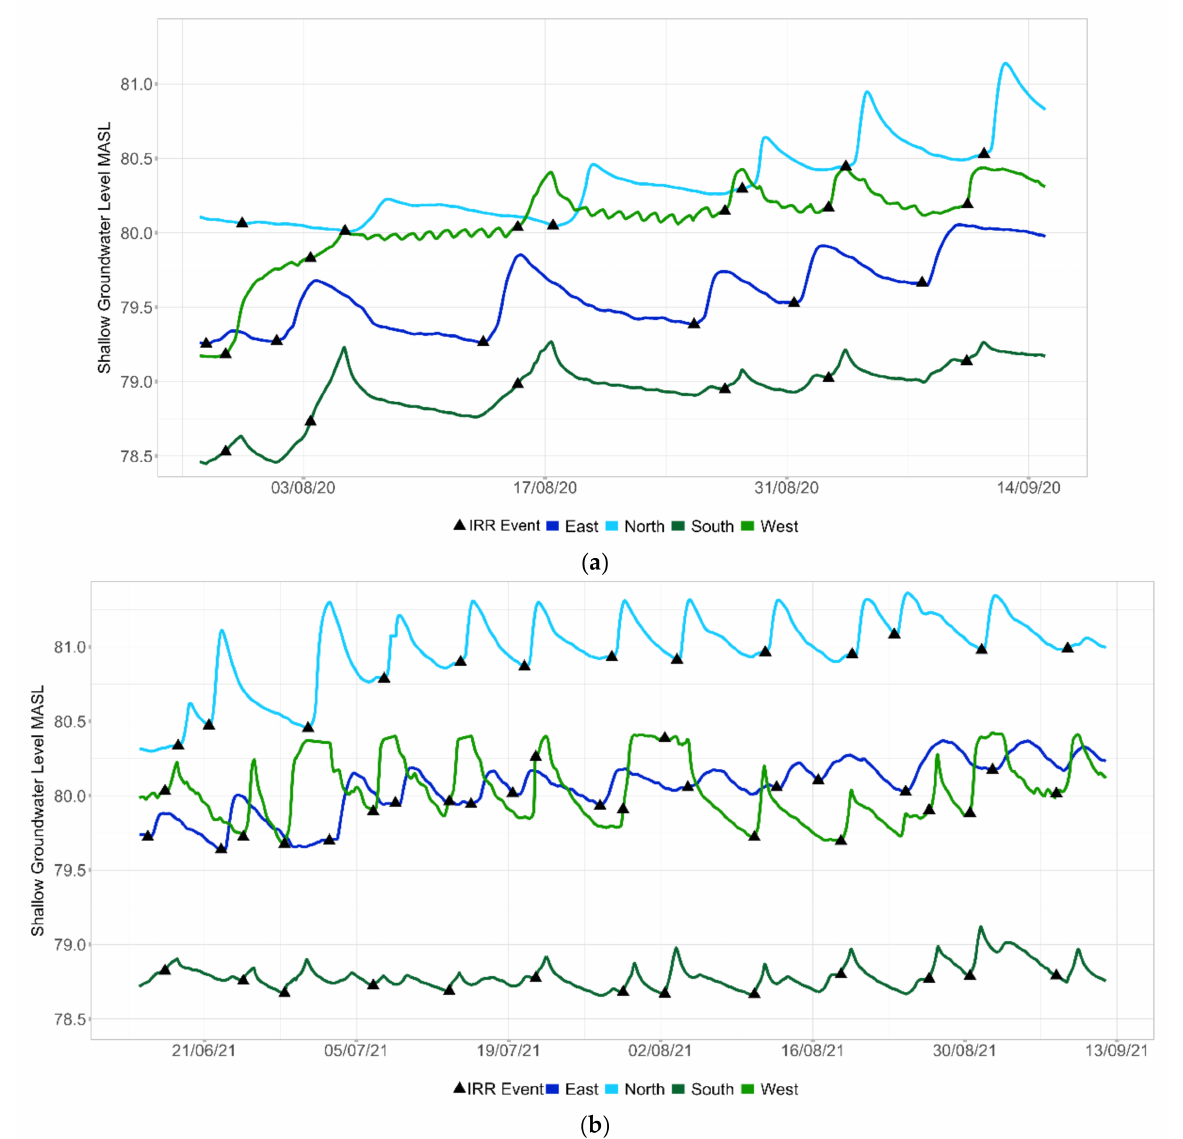
Figure 4. Daily averaged groundwater level in meters-above-sea-level (MASL) at the four monitoring wells on the experimental field during the ( a ) 2020 and ( b ) 2021 irrigation seasons. The irrigation events ( IRR ) for the area near each well location are also